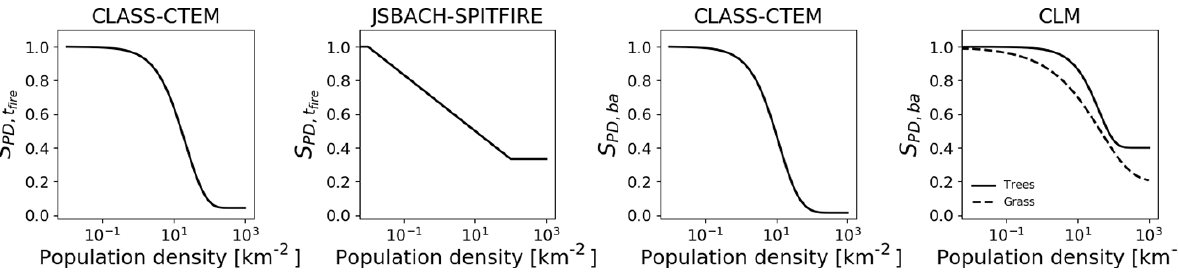
) for CLASS-CTEM and JSBACH SPITFIRE and suppression fire